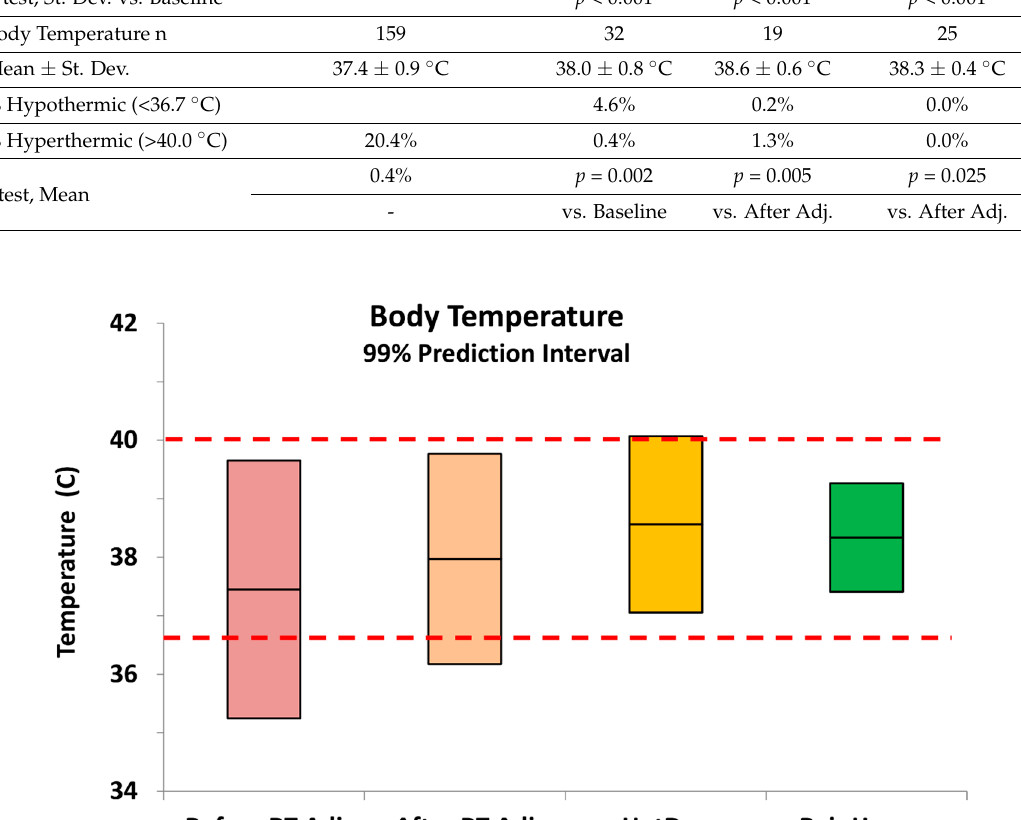
Figure 2. Intraoperative porcine body temperatures during surgery before and after room temperature adjustments, and after room temperature adjustments with addition of a supplemental heat source. For the first two measurements a circulating hot water mattress was used. Without use of a supplemental heat source there were occurrences of hypothermia. With the HotDog warmer there were a few cases of hyperthermia. There was no hypothermia or hyperthermia for the Bair Hugger. The middle line of each box is the mean value, and the range represents the 99% prediction interval from a parametric estimation.